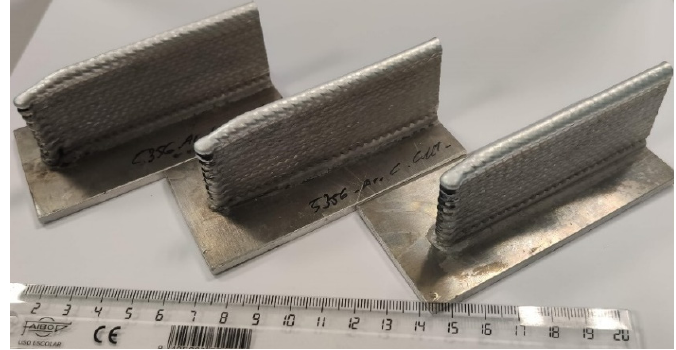
Figure 7. 20-layer aluminium wall by CMT Argon circling deposition strategy with 18 L/min (left), 25 L/min (middle), and 30 L/min (right) shielding gas flows.